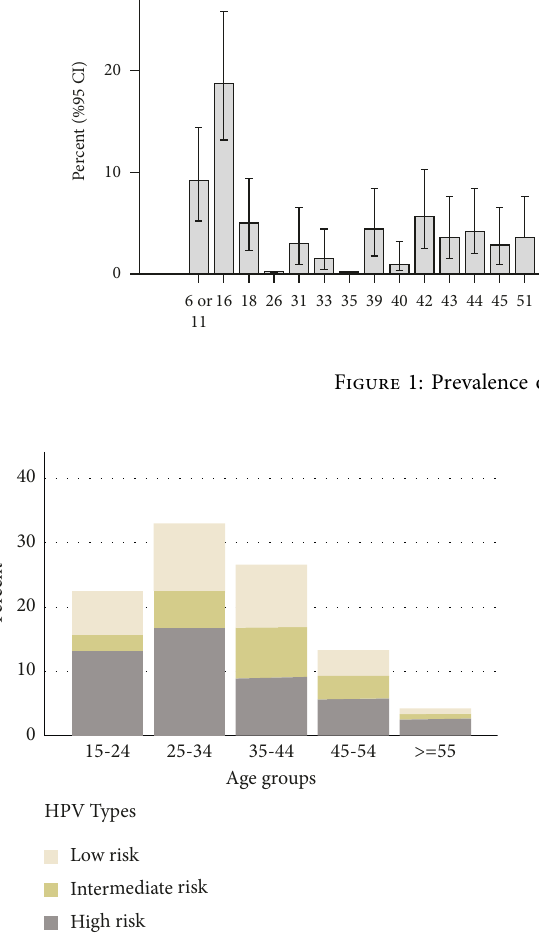
Figure 2: Prevalence of low-risk, medium-risk, and high-risk genotypes HPV based on age